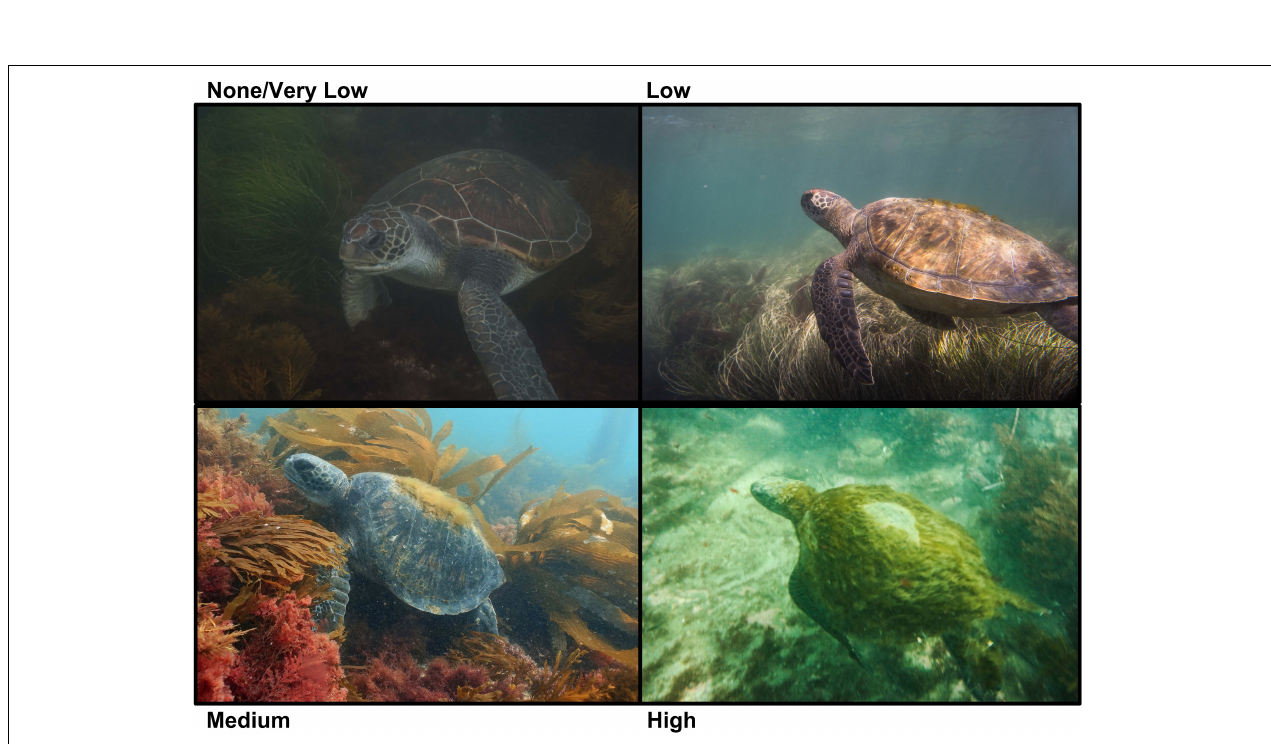
FIGURE 3 | Shows examples of the four different algae codes that indicate None/Very Low,” “Low,” “Medium,” and “High” algae accumulation on the carapace. Photographs taken by Jamie Leslie Feldman, Erin M. Chandler, and Trystan Snodgrass.